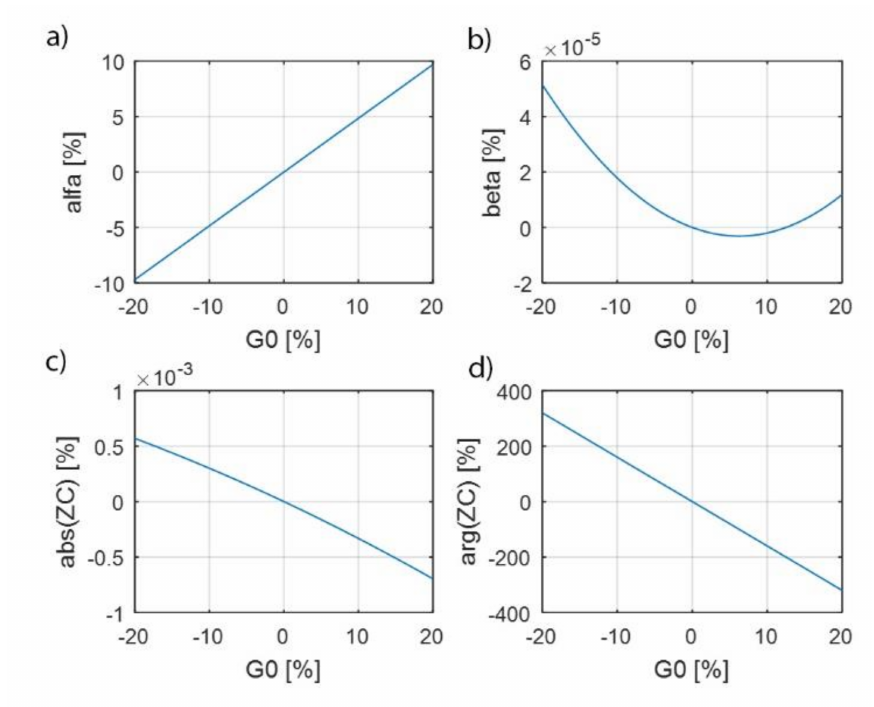
Figure 11. Changes of wave parameters depending on G 0 at f = 100 kHz; ( a ) damping factor α , ( b ) phase factor β , ( c ) wave impedance modulus, and ( d ) wave impedance argument.